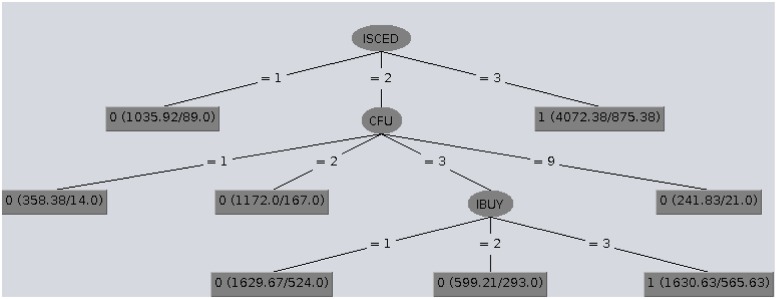
CTC tree obtained for Poland which has a very low EGUI+ level.